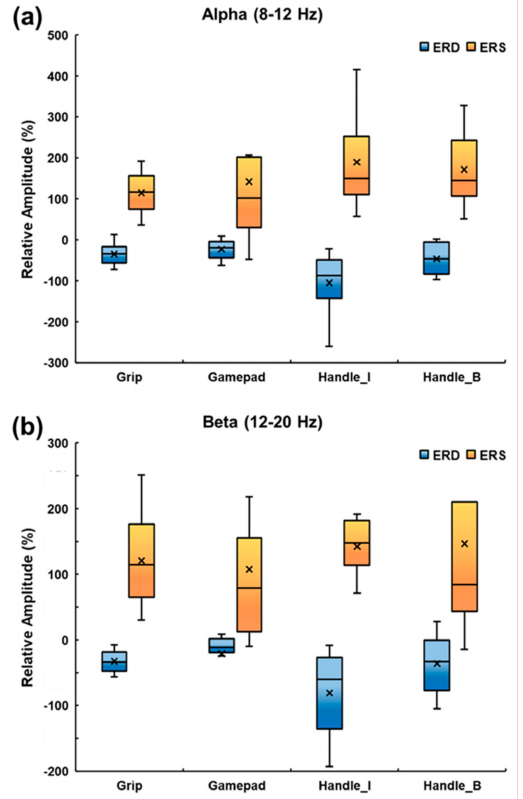
Figure 10. Box and whisker plots of the ERD/ERS peak values: ( a ) α wave (8–12 Hz); ( b ) β wave (12–20